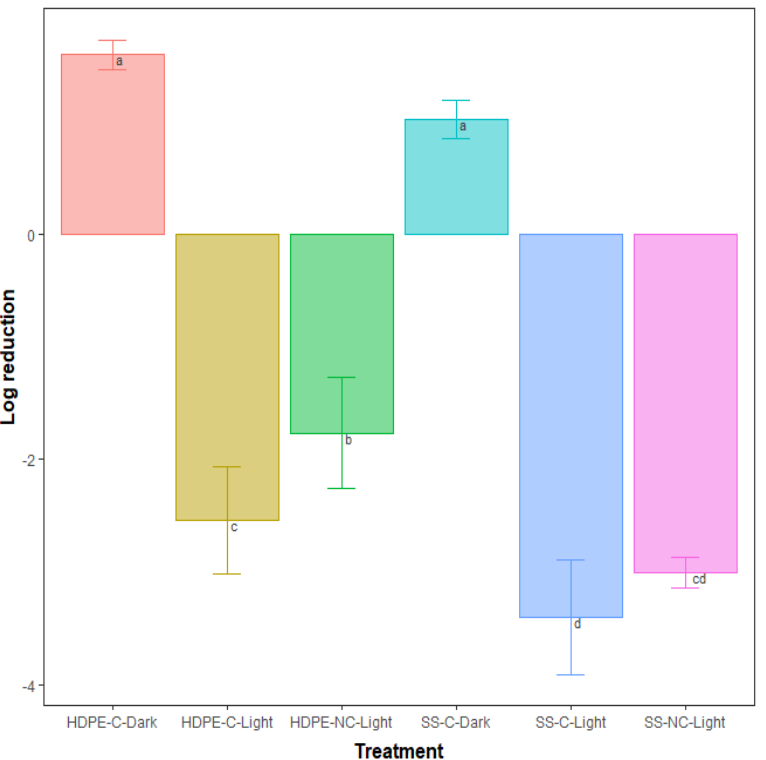
Figure 7. Logarithmic reduction of E. coli at 8 h of treatment by the P25 TiO 2 -coated materials (HDPE-C-Light, SS-C-Light) and non-coated materials (HDPE-NC-Light, SS-NC-Light) under UV- A LED radiation, and by coated materials in the dark (HDPE-C-Dark, SS-C-Dark). Error bars represent ± standard deviation of three measurements (n = 3). Treatments with the same letter are not significantly different ( p > 0.05).